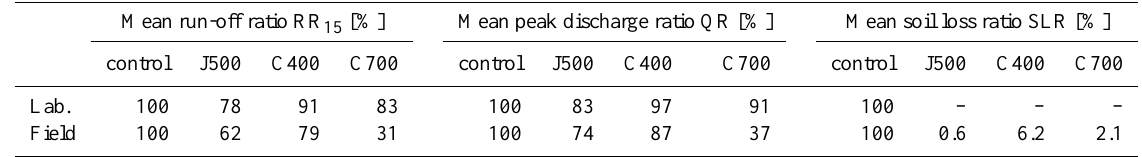
Table 5. Mean run-off ratios RR 15 [%], peak discharge ratios QR [%] and soil loss SLR [%] ratios of jute 500gm − 2 (J500), coir 400gm − 2 (C400) and coir 700gm − 2 (C700) GTXs, compared to control treatments under field and laboratory conditions.